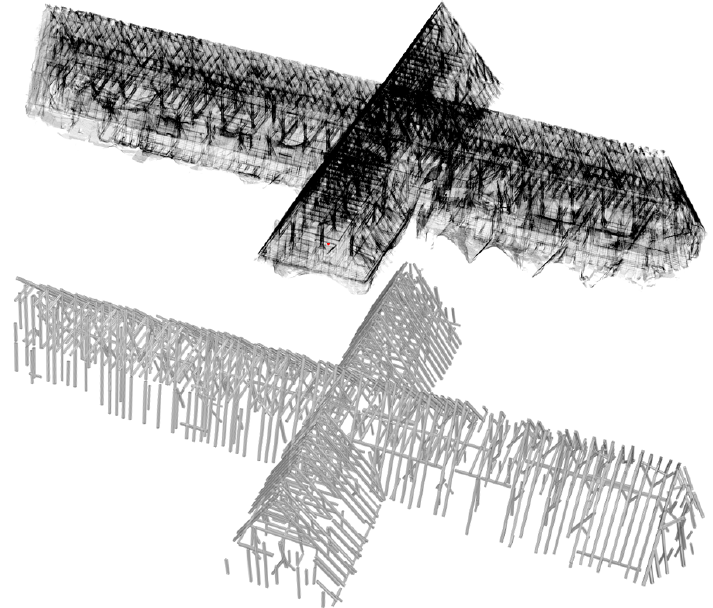
Figure 11. X-ray view of entire point cloud ( top ) and fully automated cuboid fitted beams ( bottom ).